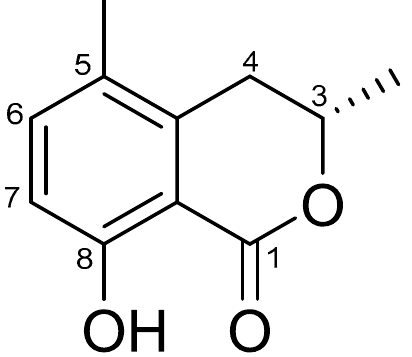
Figure 2. Chemical structure of 1 (( S )-5-methylmellein, 5MM).